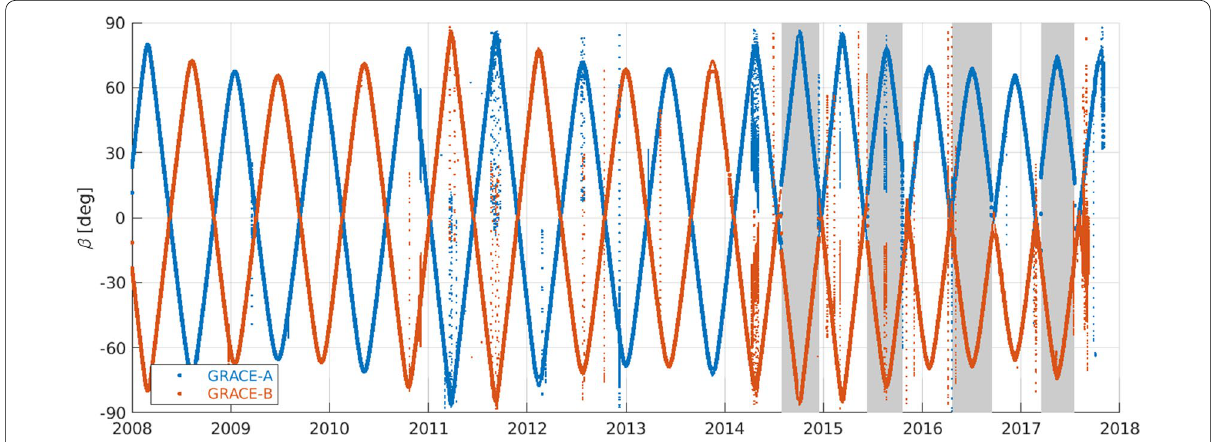
Fig. 5 Time evolution of Sun incident angle β for the two GRACE satellites. The grey-shaded area show periods when the two satellites have swapped their leading/trailing position and changed flight direction by 180